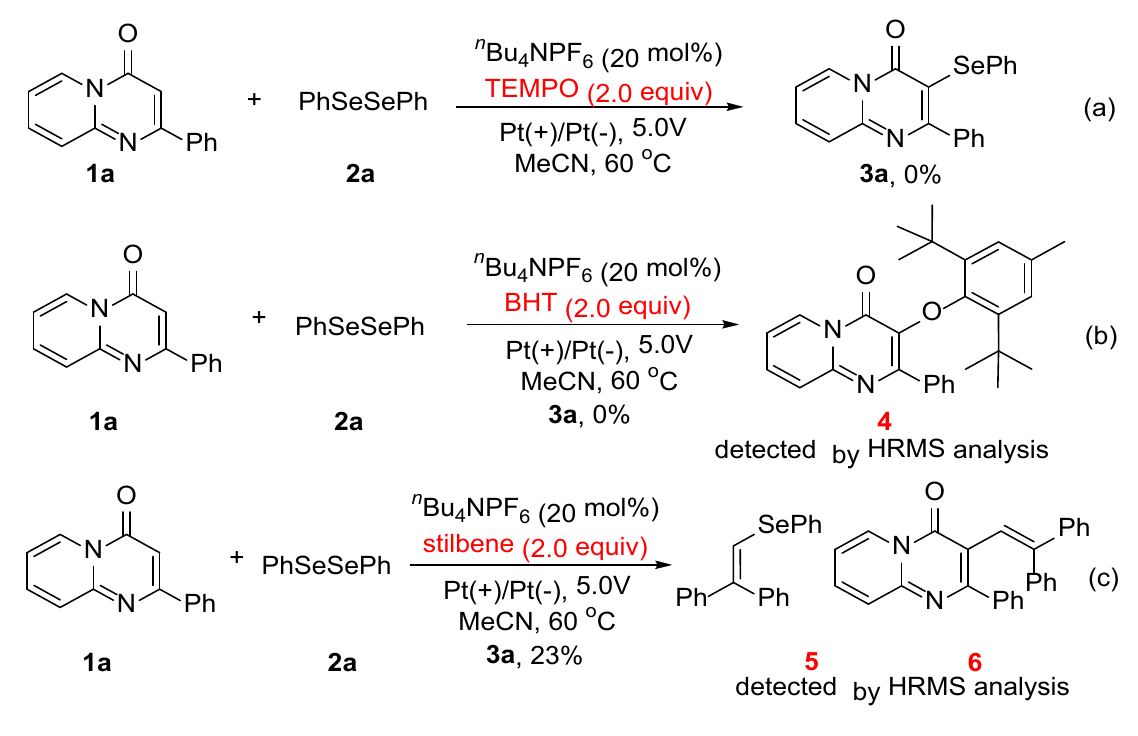
Scheme 2. Radical trapping experiments. (2 a : The control experiment in the presence of TEMPO; 2 b : The control experiment in the presence of BHT. 2 c : The control experiment in the presence of